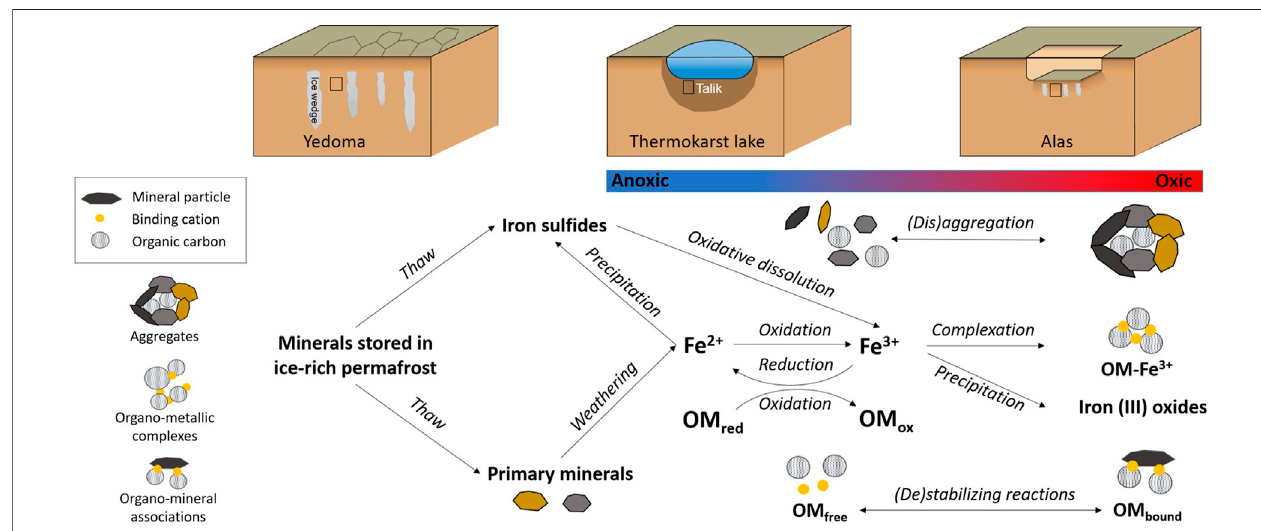
FIGURE 1 | Conceptual scheme of the biogeochemical iron (Fe) transformations expected upon thermokarst lake formation and drainage in ice-rich-permafrost (Yedoma) sediments and implications for organic matter (OM) stabilization. Black rectangles in the upper schematic representation of Yedoma, thermokarst lake and